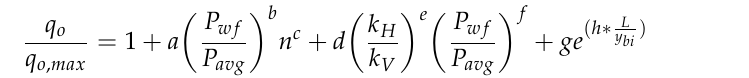
Table 2. Constant values of the modified empirical model.